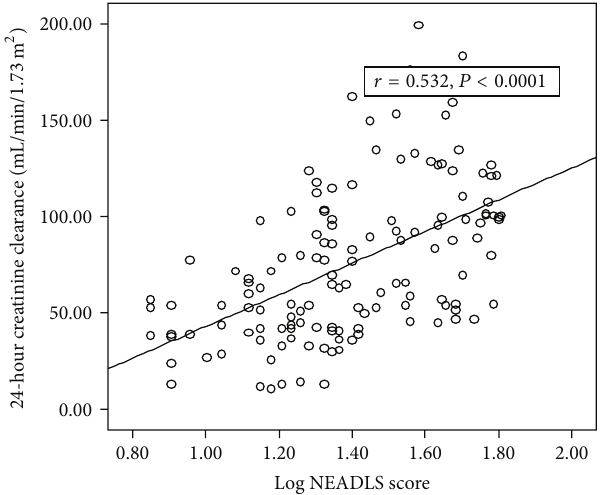
Figure 2: The scatter plot graph between logarithmically converted Nottingham Extended Activities of Daily Living Scale (NEADLS) score and 24 hour creatinine